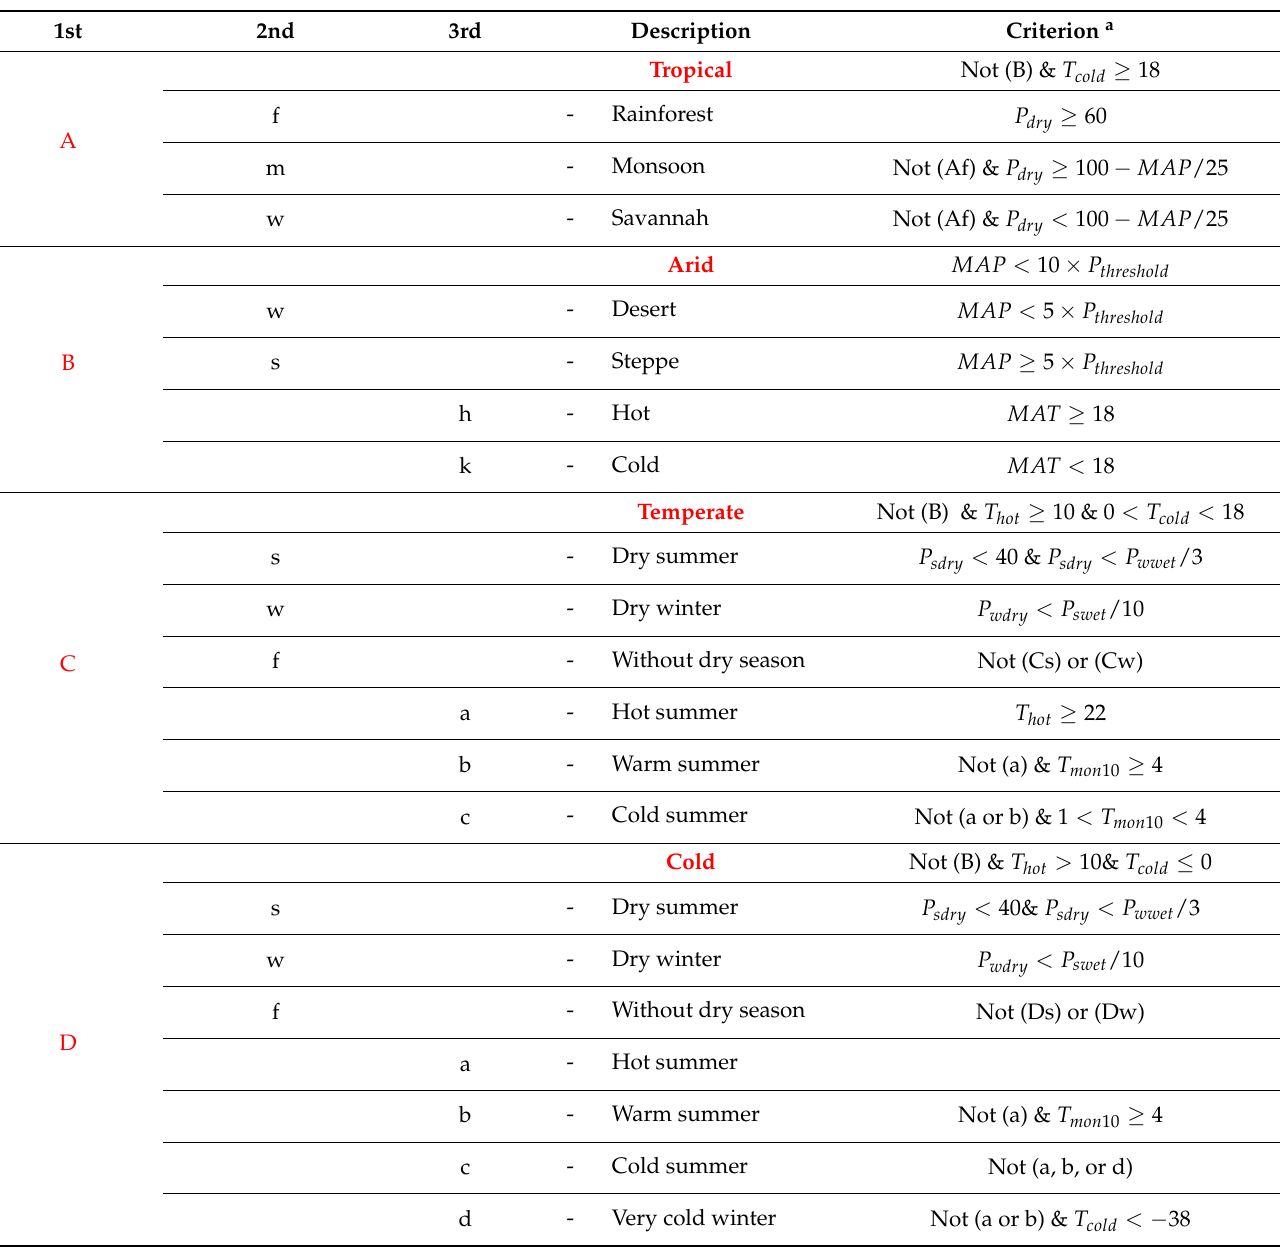
Table 1. Köppen-Geiger climate classification descriptions and corresponding criteria